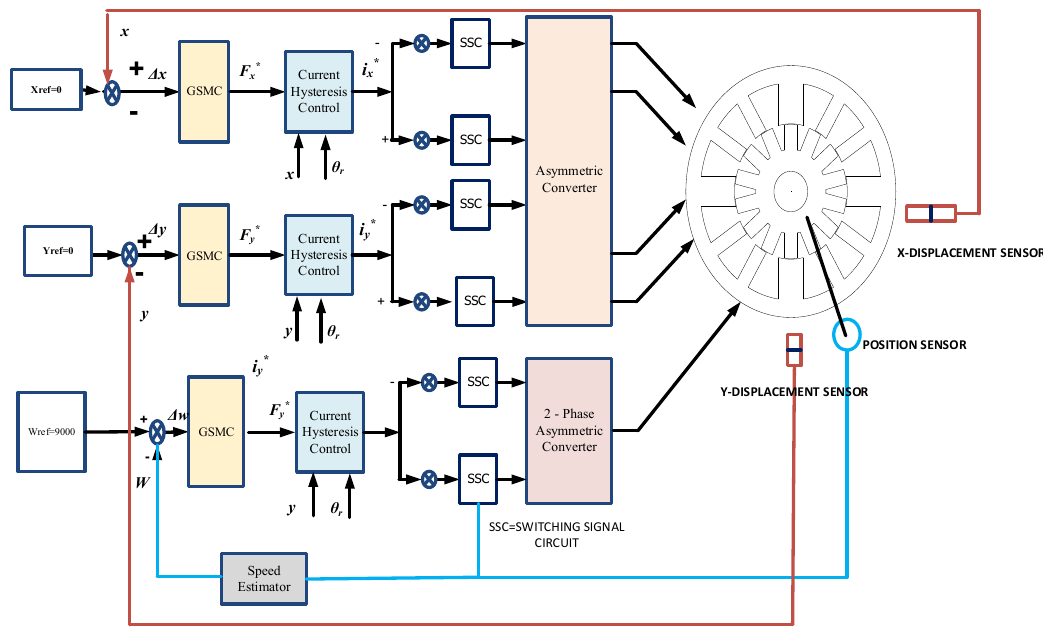
Figure 10. Complete eccentric control of 12/14 BSRM.